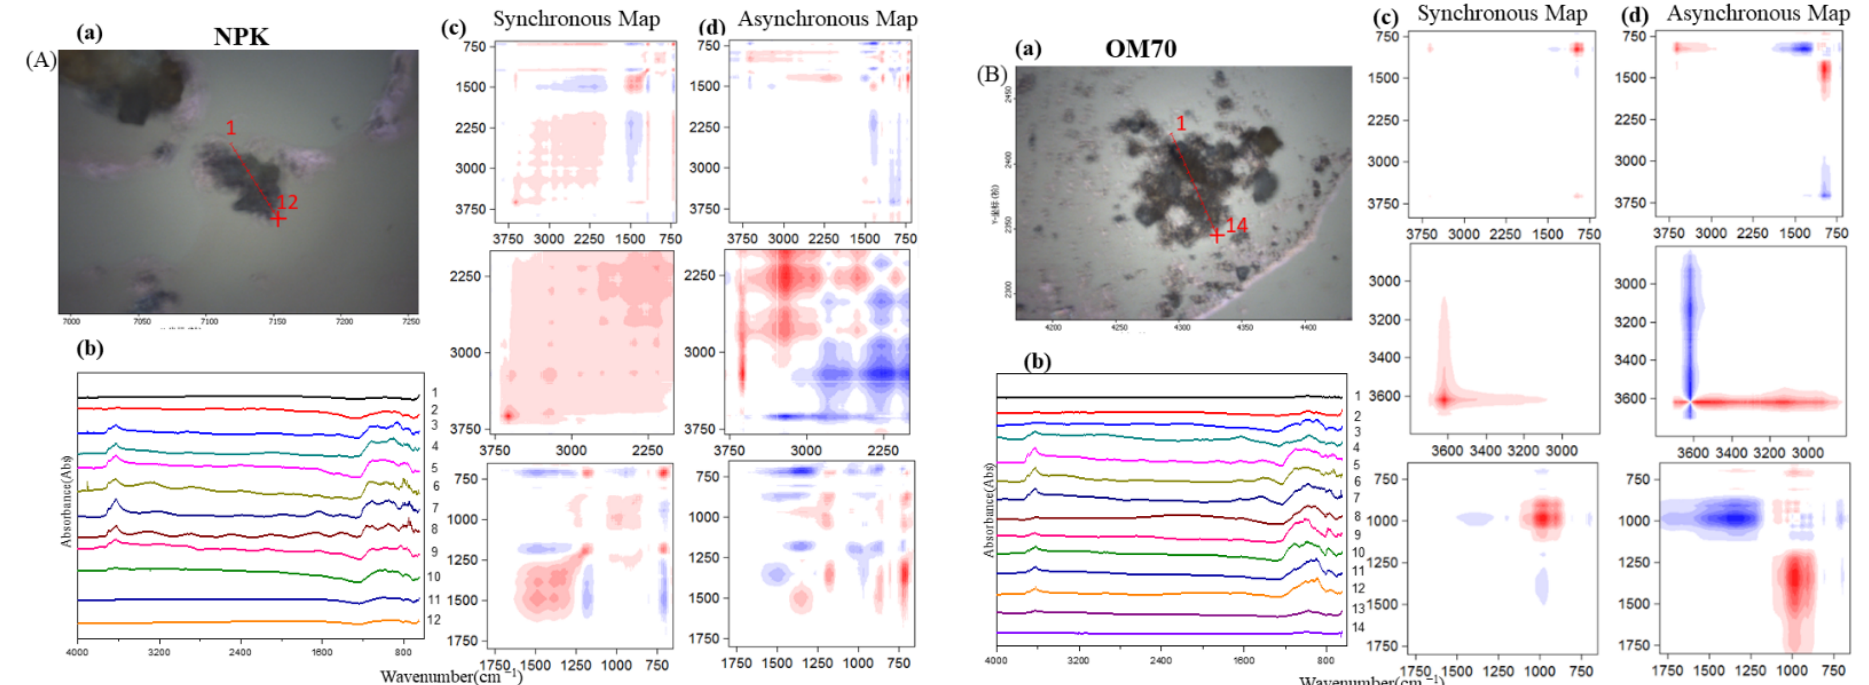
Figure 4. 1D SR-FTIR spectra and 2D correlation maps generated from the FTIR spectra of the NPK ( A ), and OM70 ( B ) treated soil. ( a ) The red line shows regions of interest (ROIs). ( b ) 1D SRFTIR spectra extracted from ROI. ( c ) Synchronous 2D correlation maps. ( d ) Asynchronous 2D correlation maps. Red represents a positive correlation, and blue represents a negative correlation; a higher color intensity indicates a stronger positive correlation.